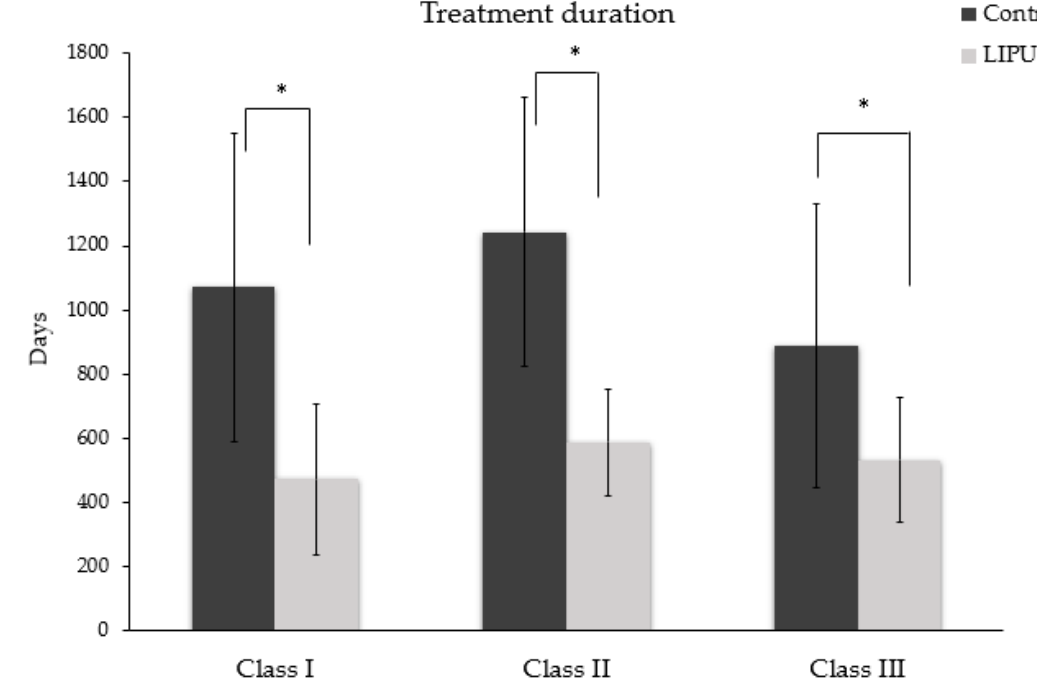
Figure 5. Average treatment duration in Class I, Class II and Class III malocclusion (* p < 0.05) .